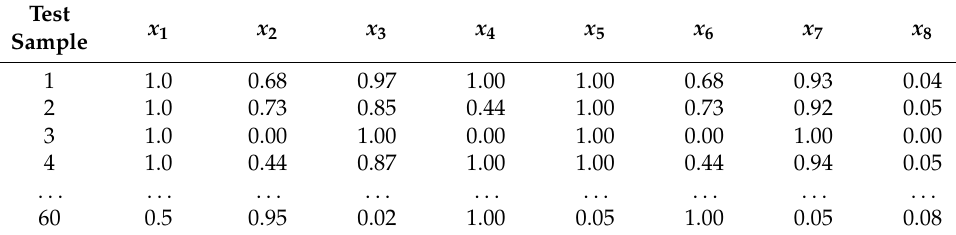
Table 5. The test